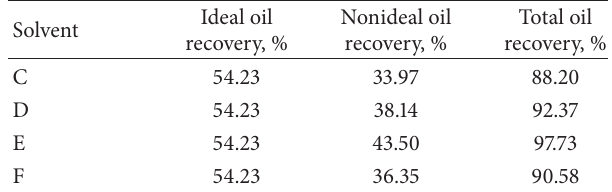
Table 3: Effect of polar